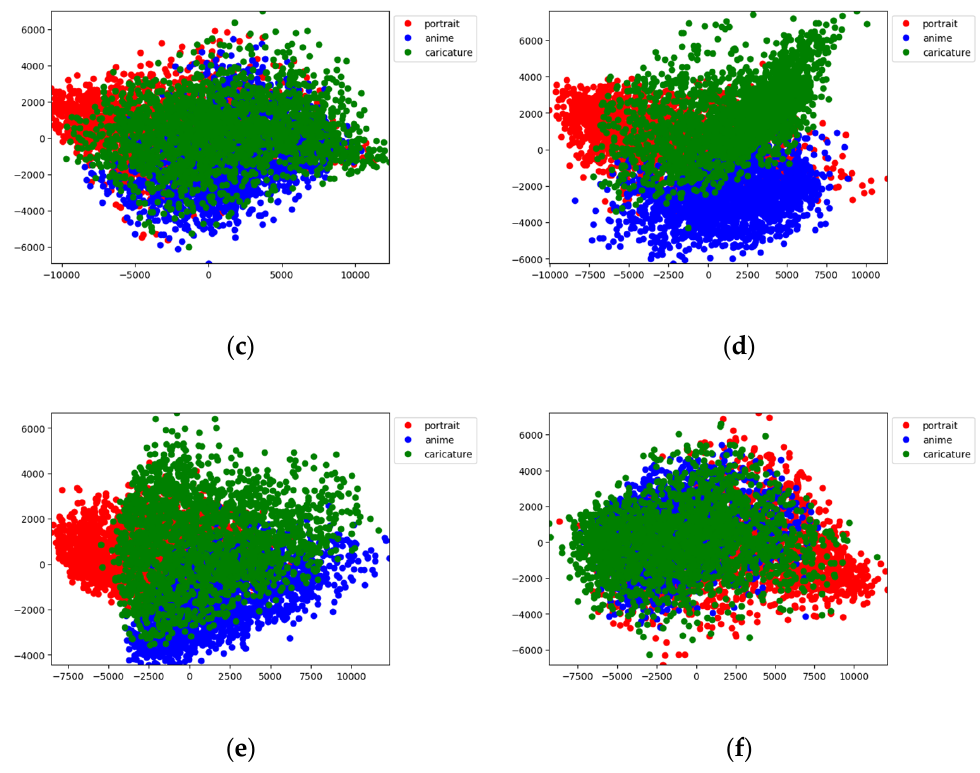
Figure 8. Results of K-means clustering using three translation models. ( a ) t-SNE with our Multi- CartoonGAN, ( b ) t-SNE clustering with CycleGAN, ( c ) t-SNE clustering with U-GAT-IT, ( d ) t-SNE clustering with NICE-GAN, ( e ) t-SNE clustering with StarGAN, ( f ) t-SNE clustering with Sin- gleGAN.